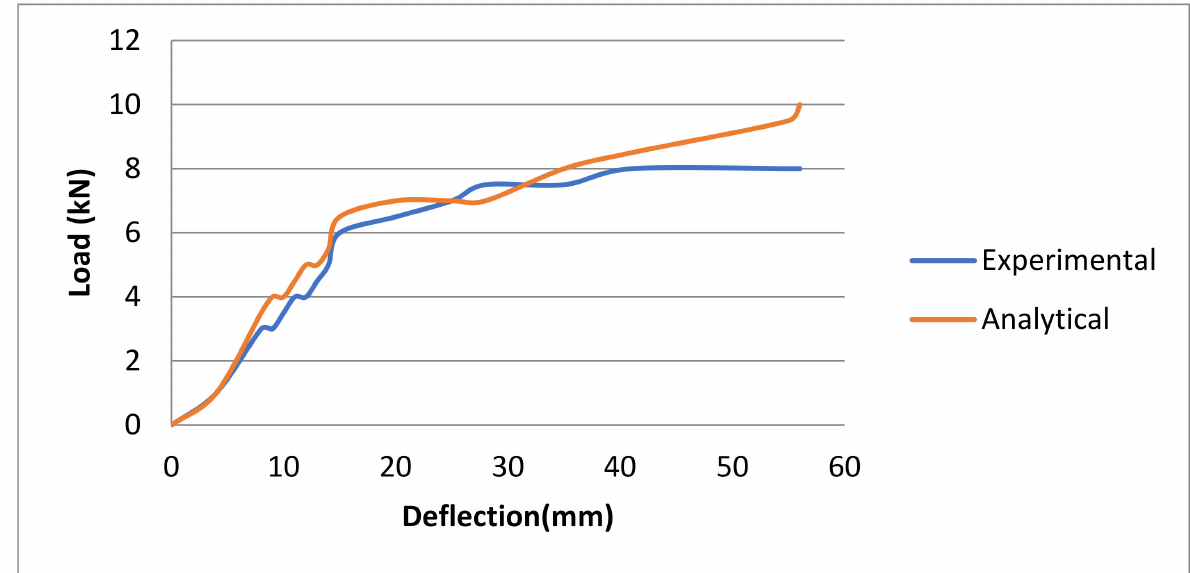
Figure 19. Load vs deflection of optimized geopolymer ferrocement panel using experimental and ABAQUS